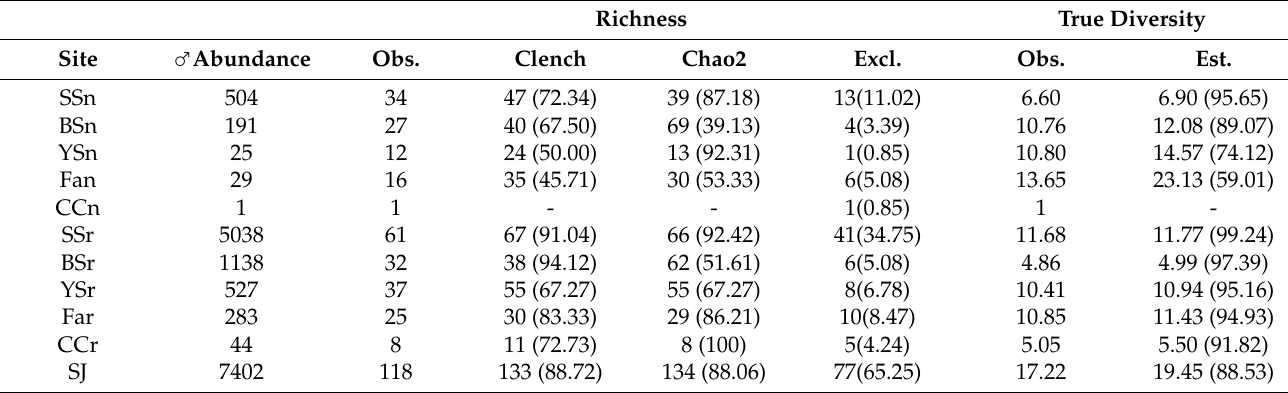
Table 4. Observed, estimated, and exclusive richness, and observed and estimated true diversity of Trichoptera in an altitudinal gradient from the Sierra de Ju á rez, Oaxaca, Mexico. In parentheses the percentage of richness and diversity obtained in the field with respect to those estimated. Richness True